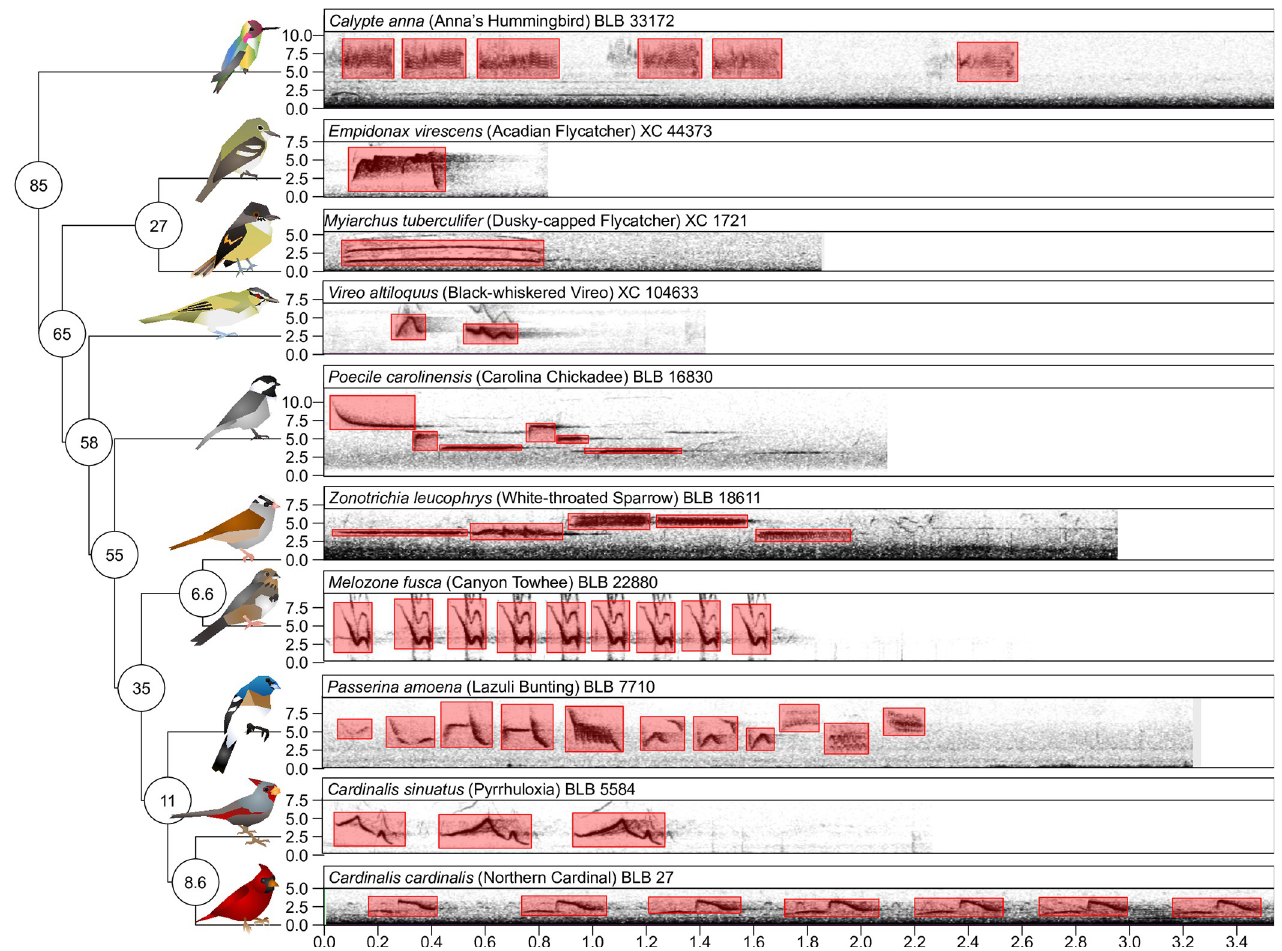
Fig 2. Species in this study varied in their song types and phylogenetic relatedness. On the left is a phylogeny describing the phylogenetic distances between ten focal species. Species are shown as artist’s renditions of birds at tips of branches. Note that birds are not to scale. Numbers in circles at nodes show approximate time of divergence (in Mya; branches and nodes not to scale). On the right, spectrograms of exemplar songs per species are shown, with frequency on the y-axis (in kHz) and time on the x-axis (in seconds). Scientific, common names, and recording identification are shown above the spectrogram, where BLB = Borror Laboratory of Bioacoustics and XC = Xeno-Canto. Red boxes show the annotations that were manually put on per